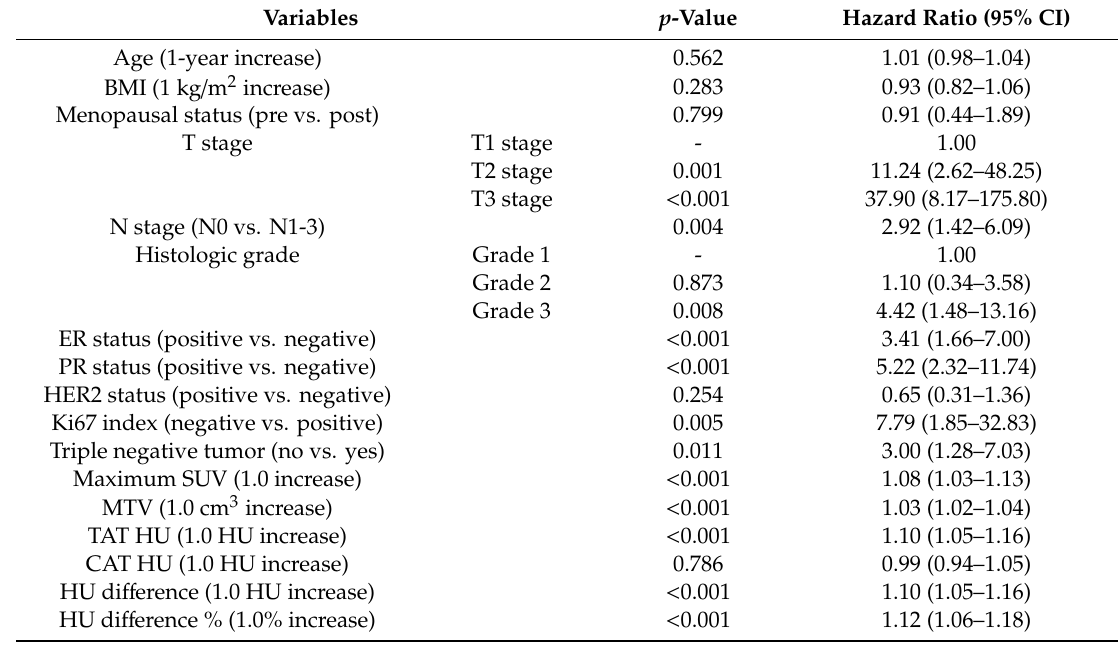
Table 3. Univariate analysis for recurrence-free survival.